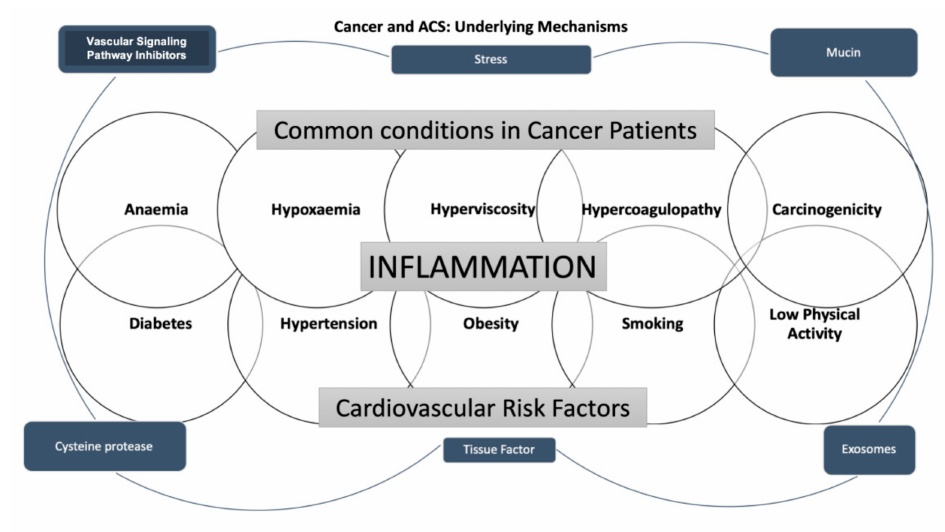
Figure 2. The scheme summarizes the underlying mechanisms of the associations between cancer and acute coronary